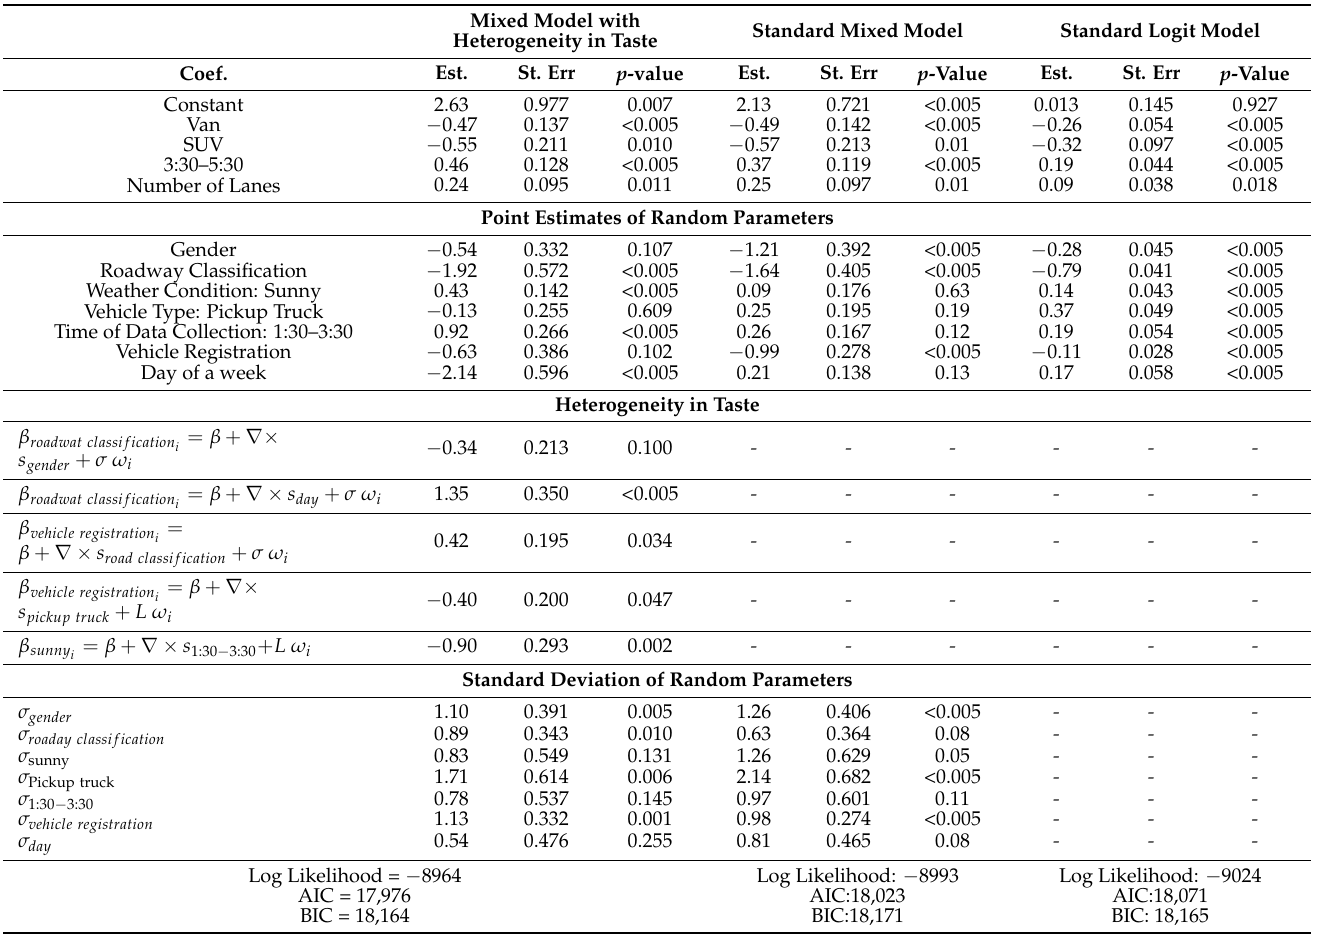
Table 2. Estimation results of three considered